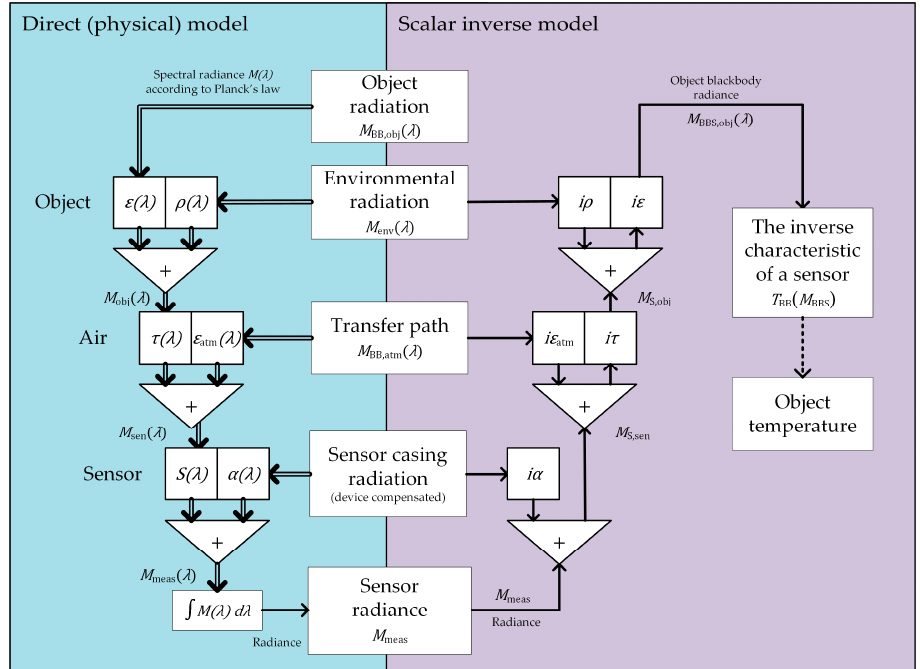
Figure 10. Model of radiation thermometry with the scalar inverse model. Parameters, beginning with i correspond to scalar instrumental parameters. Dotted lines represent transfer of non-radiation scalar data, such as temperature or calculated scalar equivalent of an influence parameter. The inverse black body radiance characteristic is a characteristic transformation between emitted radiance and temperature of a black body, which can be derived from Planck’s law.